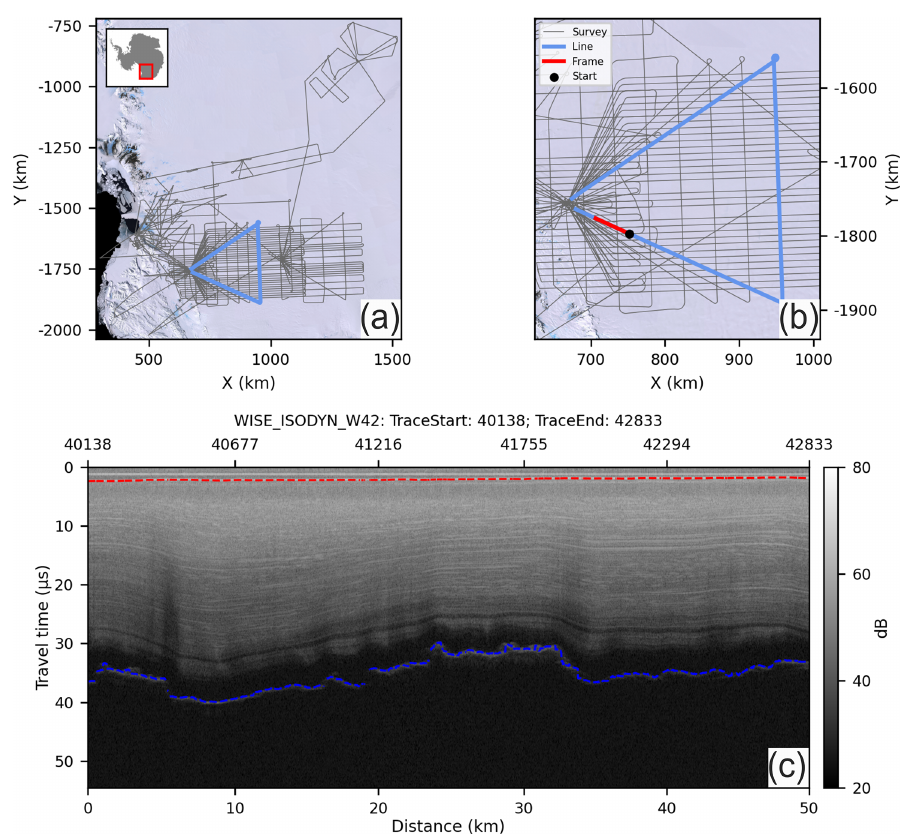
Figure 7. Example of a segmented quick-look image from the 2005–2006 WISE-ISODYN survey. (a) Overview map of the survey flight lines (grey lines) with an inset over Antarctica and the specific flight line highlighted in blue. (b) Zoomed in version of (a) showing the specific flight line with the footprint of the 50km segment (red line) and start point for the radargram (black dot) shown in (c) . The background satellite image in (a) – (b) is from the Landsat Image Mosaic of Antarctica (LIMA) (Bindschadler et al., 2008). (c) 50km segmented radar image of the chirp data with distance in kilometres shown in the bottom x axis and the trace number shown in the top x axis. The y axis shows the travel time in microseconds. The format of the title in (c) is as follows: survey name and flight ID, first trace of segment, last trace of segment. The dashed red and blue lines on the radargram in (c) show the surface and bed pick,